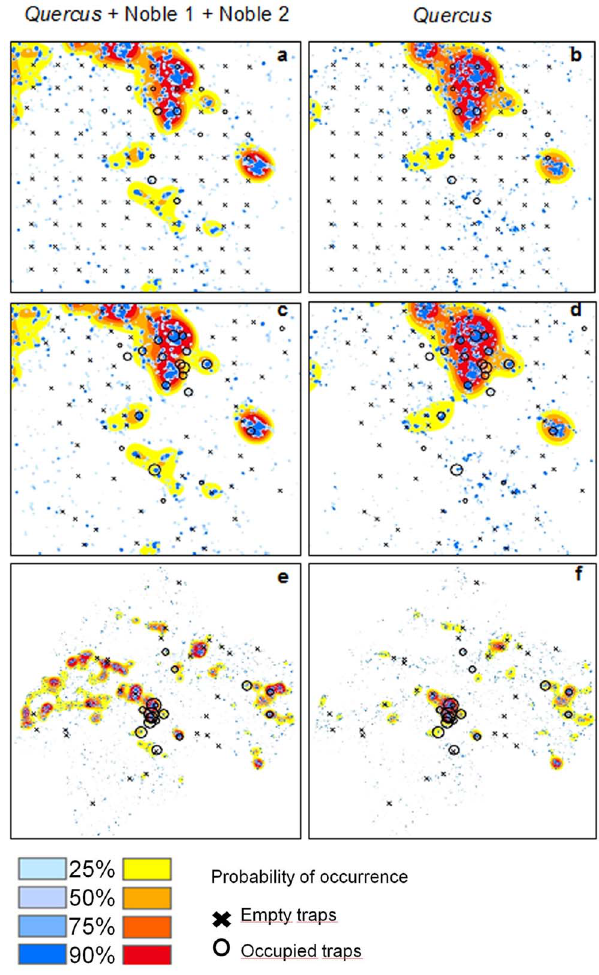
Figure 6. Maps of predicted occurrence of Elaterferrugineus. The maps show . 25%, . 50%, . 75% and . 90% probability of occurrence in the study area ( a,b,c,d ) and in the county of O¨stergo¨tland ( e,f ) and the trap capture. Empty traps are presented by crosses ( 6 ) while occupied traps are marked with open circles ( O ) which size is proportional to the number of individuals caught. The first column ( a,c,e ) shows predictions based on models including the pooled density of trees within the groups Quercus , Noble 1 and Noble 2, while the second column ( b,d,f ) shows predictions based on models including the density of Quercus only. ( a,b ) shows trap captures in systematically placed traps, ( c,d ) the strategically sampled validation data and ( e,f ) the validation data set sampled in the entire O¨ stergo¨t- land. In each map, the predictions are based on two models, one for each characteristic scales of response (blue tones represent a smaller scale: 433 m (pooled density of Quercus , Noble 1 and Noble 2) and 327 m (density of Quercus only), while orange tones represent prediction at larger scale: 4051 m ( Quercus , Noble 1 and Noble 2) and 4658 m ( Quercus ). of hollow trees across the experimental area. The calculated densities for 50% probability of occurrence changed moderately depending on scale, dropping from 0.30 to 0.10 oaks ha 2 1 from the smallest to the largest radius considered (Figure 8). If, on the other hand, models were created from the ‘‘strategically sampled data set’’, tree densities for 50% occurrence was substantially higher when considering small to intermediate scales compared with models based on the systematically samples data. An evident